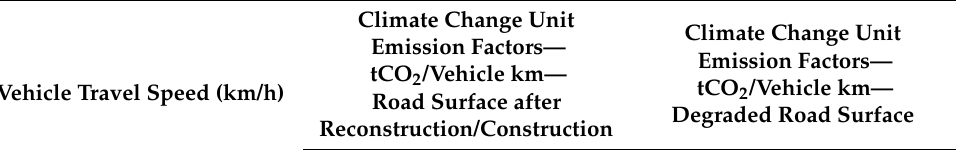
Table A6. Climate change unit emission factors tCO 2 /vehicle km, flat terrain: road surface after reconstruction/construction and degraded road